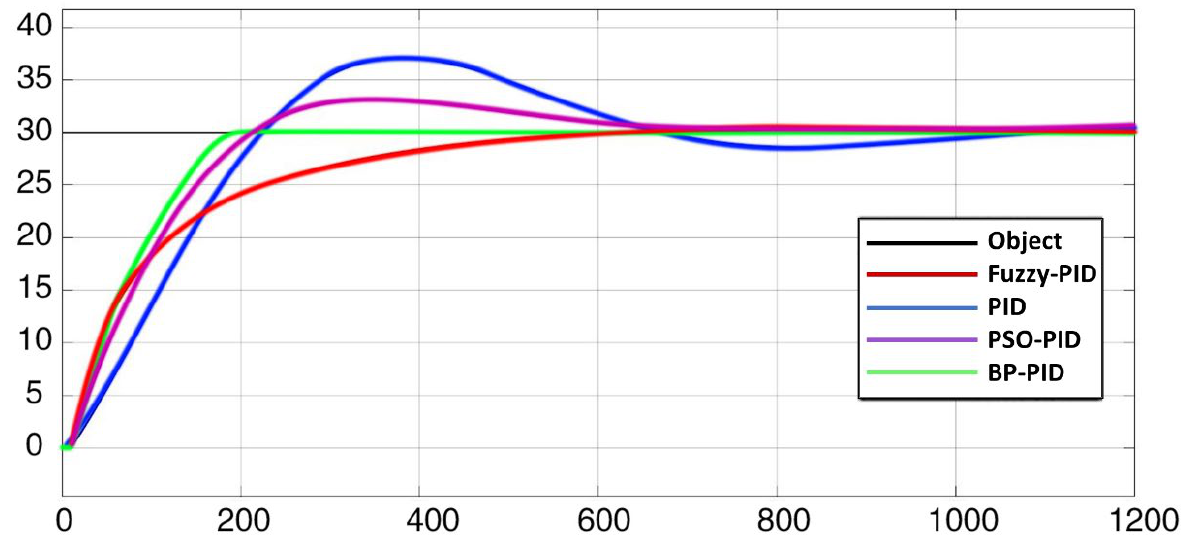
Figure 13. Heating response curve of the controlled object.